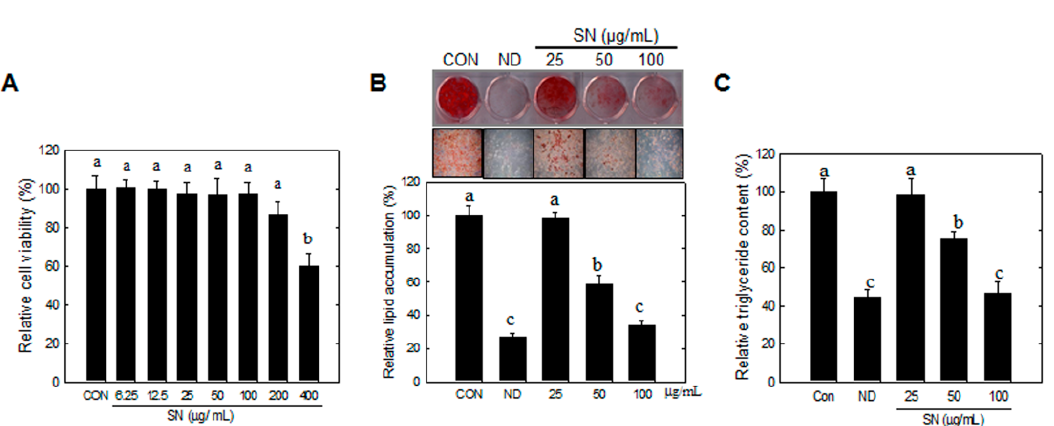
Figure 2. Effects of SN on the expression of adipogenic factors and triglyceride synthetic enzymes in adipocyte. ( A ) Late adipogenic factors were assessed by Western blotting; and ( B ) levels of triglyceride synthetic enzymes were quantified using the ImageJ software; ( C ) Fatty acid synthase enzymes were assessed by Western blotting; and ( D ) levels of triglyceride synthetic enzymes were quantified using the ImageJ software. Differentiated or undifferentiated cells were harvested at day 6 for extraction of proteins, which were subjected to Western blotting. CON: control, SN: seapolynol, ND: non-differentiated 3T3-L1. Data are presented as means ± SD from three replicates. Means not designated by a common superscript are significantly different ( p < 0.05).